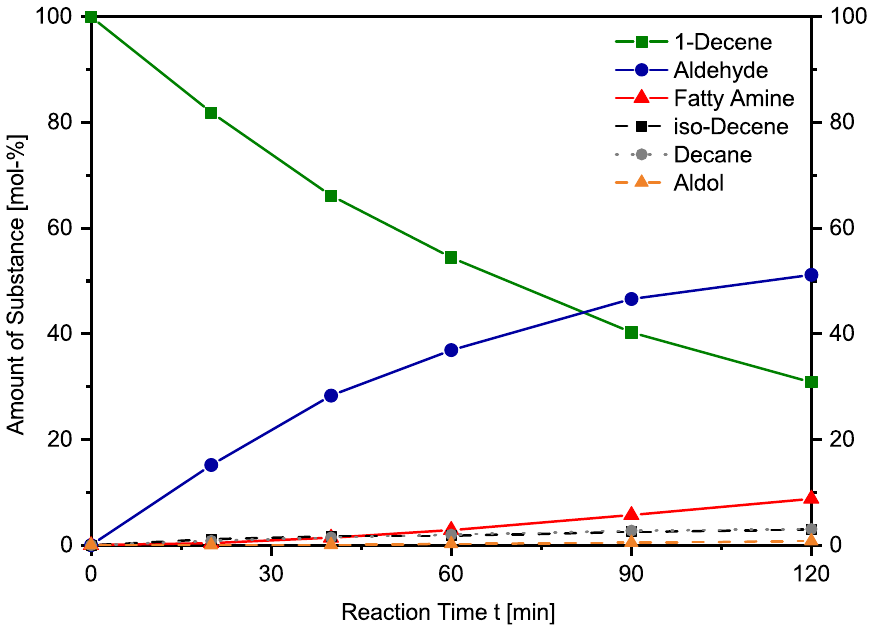
Figure 2. Concentration profile for the hydroaminomethylation of 1-decene with diethylamine in an aqueous microemulsion system. Reaction conditions: p=30bar H 2 /CO 2:1, 0.23mol% Rh, 0.92mol% NP8, 1wt% Na 2 SO 4 , 1200rpm, t=4h.